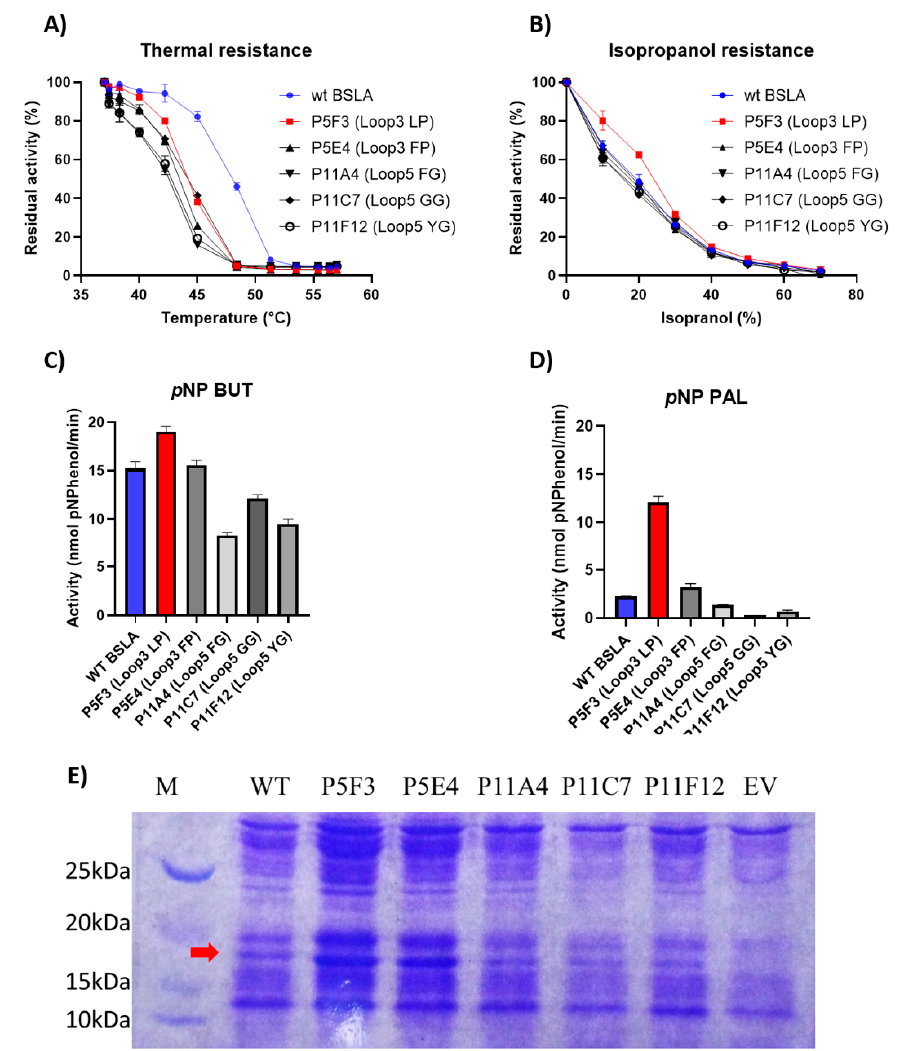
Figure 3. Comparison of the performance of WT BSLA and P5F3 (Lib 3 LP, F41L- ∆ W42- ∆ D43-K44P), P5E4 (Lib 3 FP, F41- ∆ W42- ∆ D43-K44P), P11E4 (Lib 5 FG, R107F- ∆ L108- ∆ T109-T110G), P11C7 (Lib 5 GG, R107G- ∆ L108- ∆ T109-T110G), and P11F12 (Lib 5 YG, R107Y- ∆ L108- ∆ T109-T110G) identified from the deletion / randomization libraries. Thermal resistance after 30 min incubation 37–57 ◦ C. ( A )